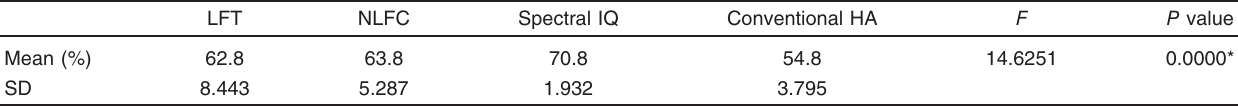
Table 7 Aided speech discrimination test results LFT